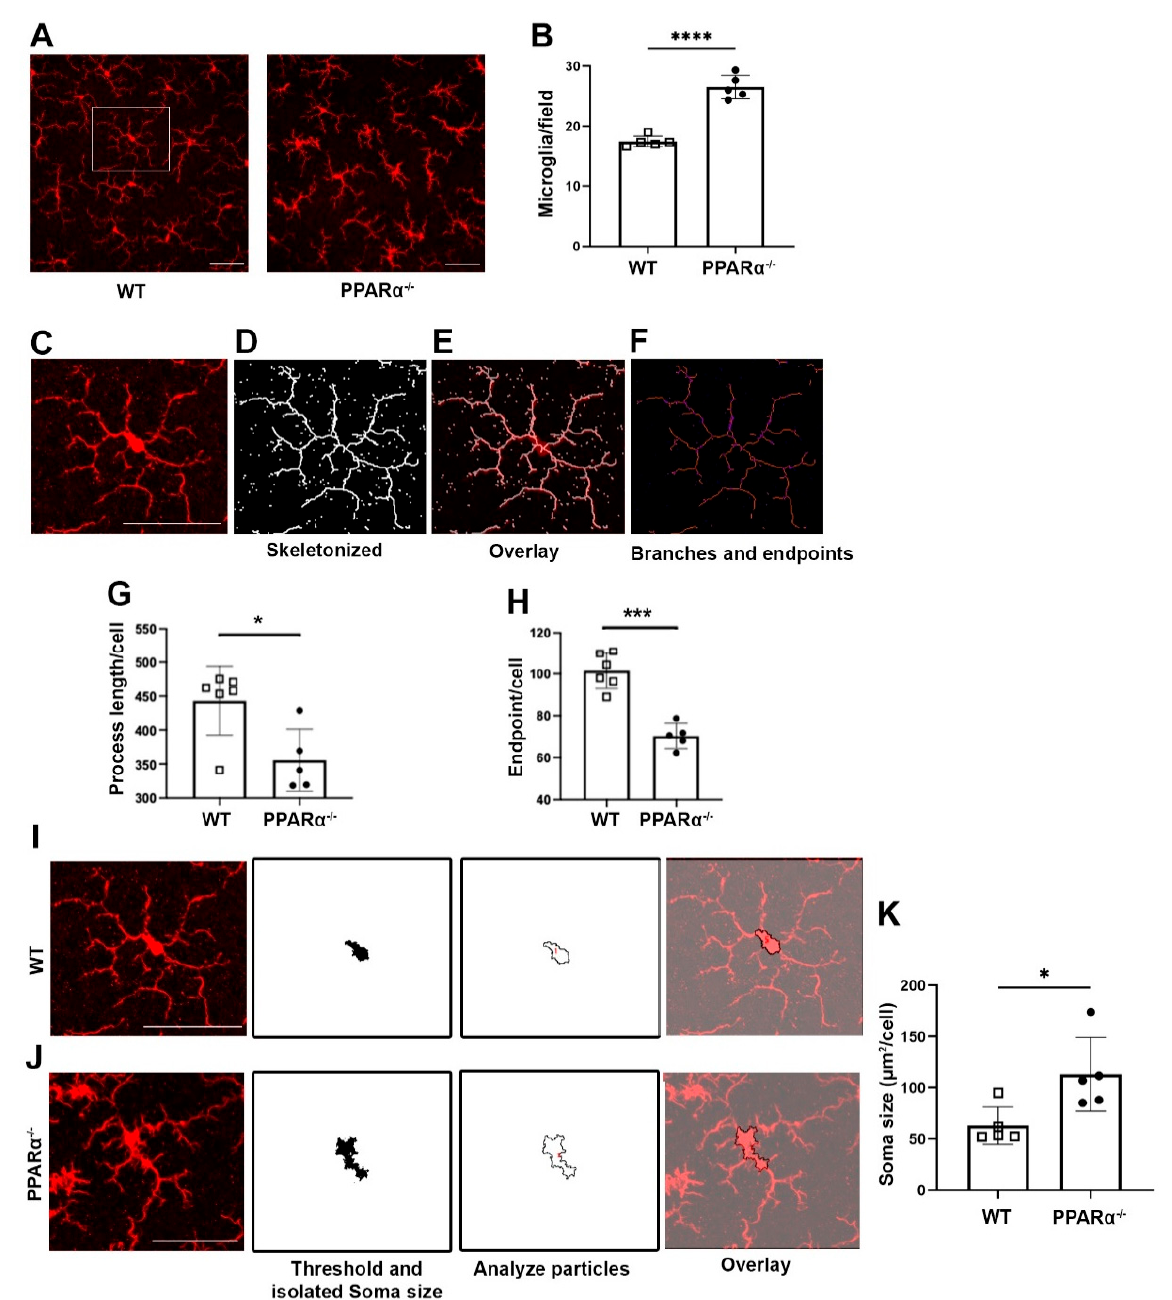
Figure 1. Microglial activation in Ppara − / − retinas. ( A ) Representative flat-mounted retina from 9-month-old Wild-type (WT) and Ppar α − / − mice stained with anti-Iba1 antibody. ( B ) Microglia counts in WT and Ppar α − / − retinas. ( C – F ) Microglial morphological analysis with Fiji ImageJ. Images were skeletonized ( D ) and overlaid with original images ( E ) to verify accuracy. Branches and intersections were labeled ( F ). ( G , H ) Quantification of microglial branch length ( G ) and endpoints ( H ) in WT and Ppara − / − retinas. ( I , J ) Cell bodies were isolated from images of WT ( I ) and Ppar α − / − ( J ) retinas. ( K ) Quantification of WT and Ppar α − / − microglial soma size. n = 5–6. Data are presented as means ± SD. * p < 0.05, *** p < 0.001, **** p < 0.0001, Student’s t -test. Scale bar: 50 µm.